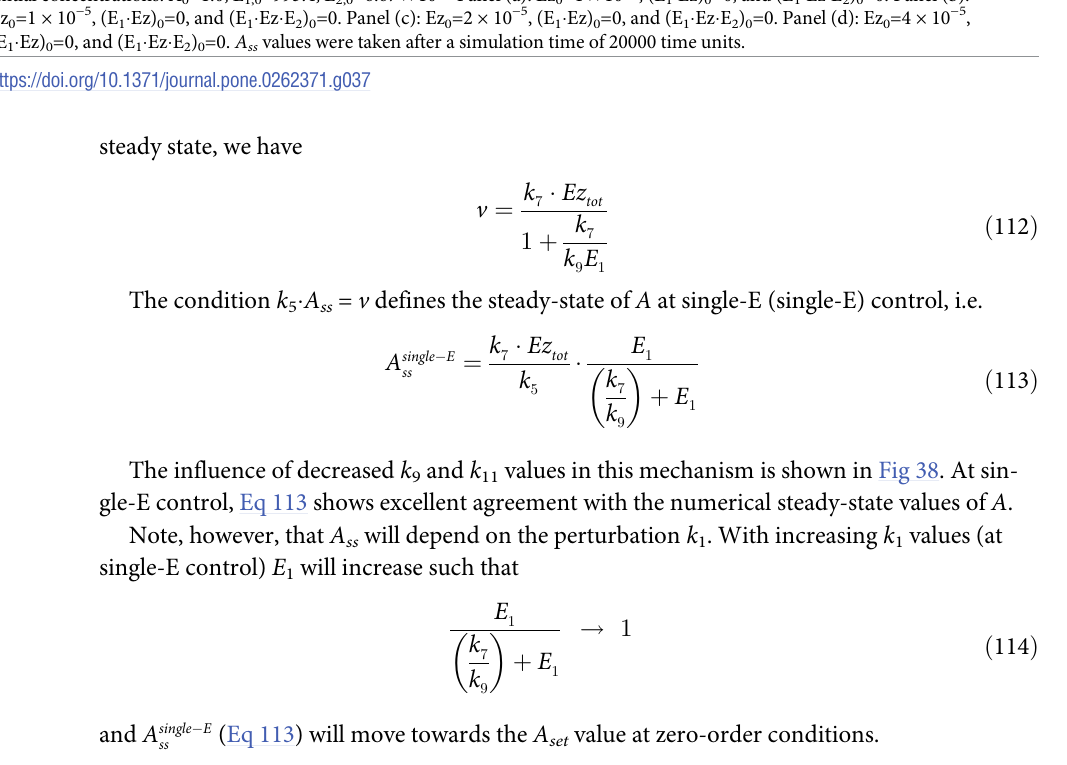
(Eq 113) will move towards the A